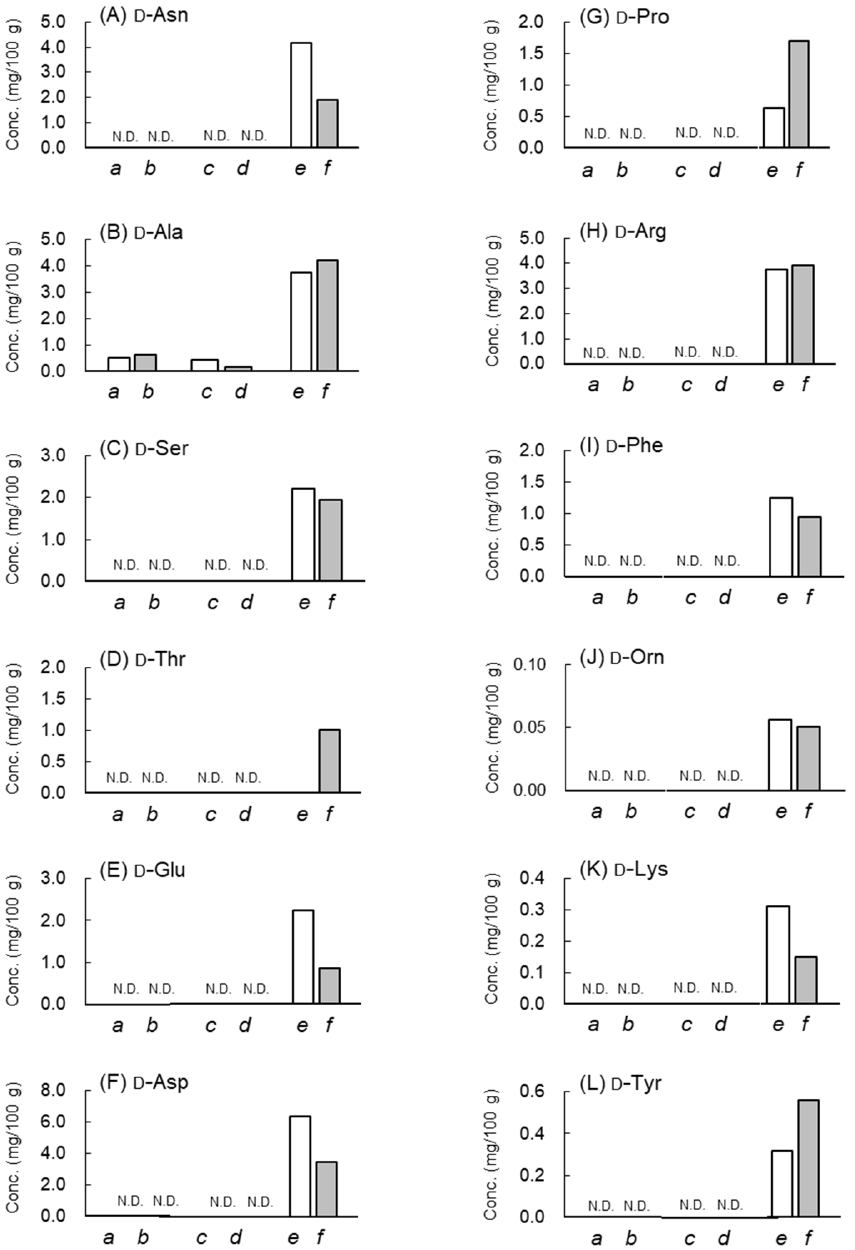
Figure 3. Concentrations (mg/100 g) of free D -amino acids in samples of grated raw garlic ( a , b ), freeze-dried garlic ( c , d ), and fermented BG ( e , f ), as determined in duplicate. ( A ) D -Asn, ( B ) D -Ala, ( C ) D -Ser, ( D ) D -Thr, ( E ) D -Glu, ( F ) D -Asp, ( G ) D -Pro ( H ) D -Arg, ( I ) D -Phe, ( J ) D -Orn, ( K ) D -Lys, ( L ) D -Tyr. N.D.: not